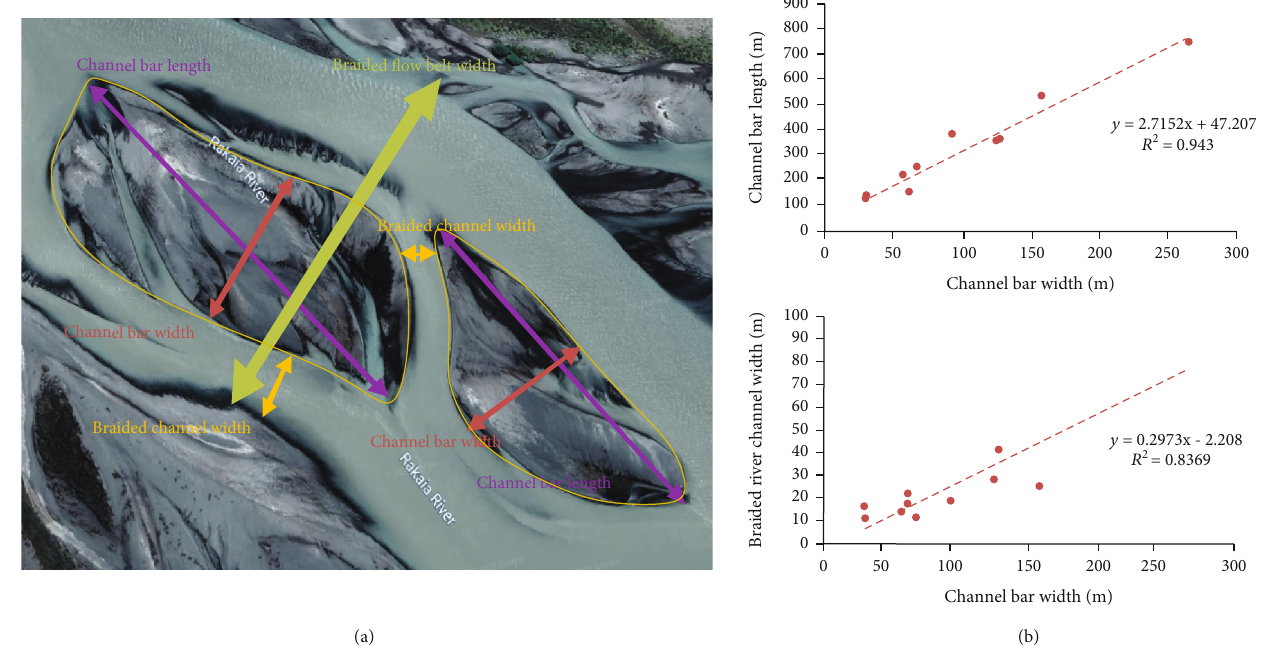
Figure 8: Sedimentary scale of the modern typical wandering braided rivers. (a) The demonstration measurements of the channel bars, the braided channels, and a single braided fl ow belt based on Google Earth, taking the Rakaia River for example. (b) The relationships between the channel bar ’ s length and the channel bar ’ s width and between the channel bar ’ s width and the braided channel ’ s width based on the result